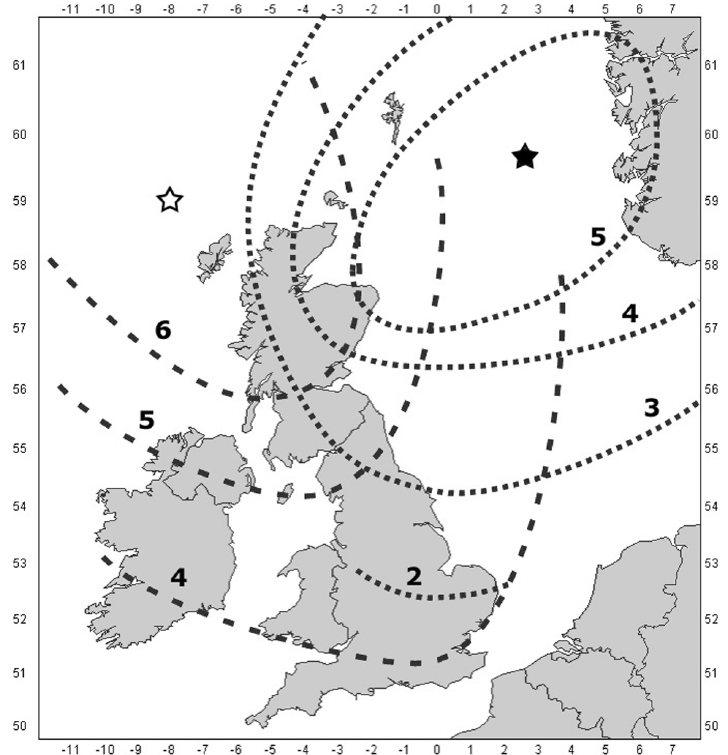
Fig. 3. Two possible analogues for the 1508 earthquake. Broad dashes indicate a worst case scenario for an oc- currence of an event equal to the 1929 Grand Banks (Canada) earthquake off the NW of Scotland (open star indi- cates assigned epicentre); variations involving a smaller magnitude or change of isoseismal orientation can easily be imagined. Fine dashes are the isoseismals of the 1927 North Sea earthquake (black star indicates